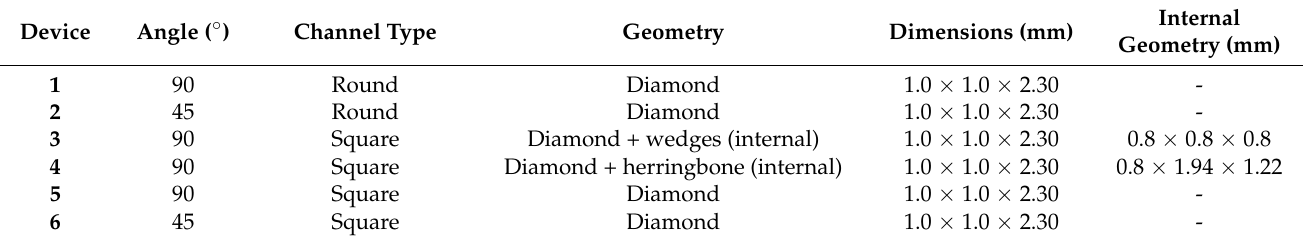
Table 1. Summary of the DPL 3DP MF device